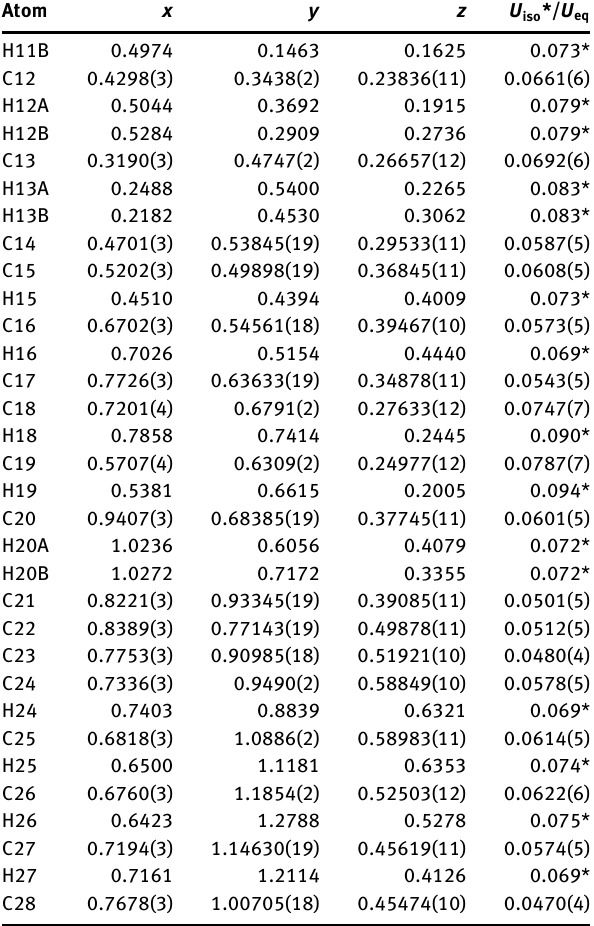
tively. The packing structure shows some weak non-classical hydrogen